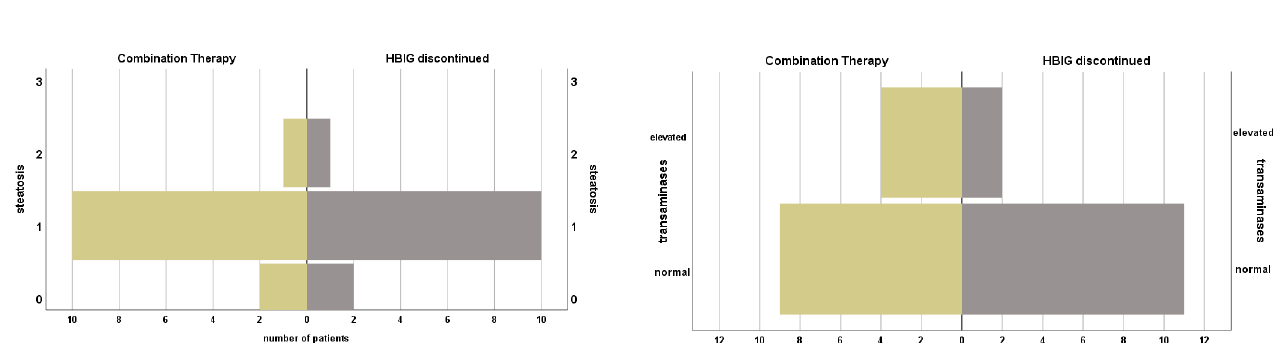
Figure 3. Course of histopathological findings and serum transaminases of patients under prophylactic combination therapy with NA + HBIG and after discontinuation of HBIG. Median time between biopsies: 120.0 (1.0–360.0) months.